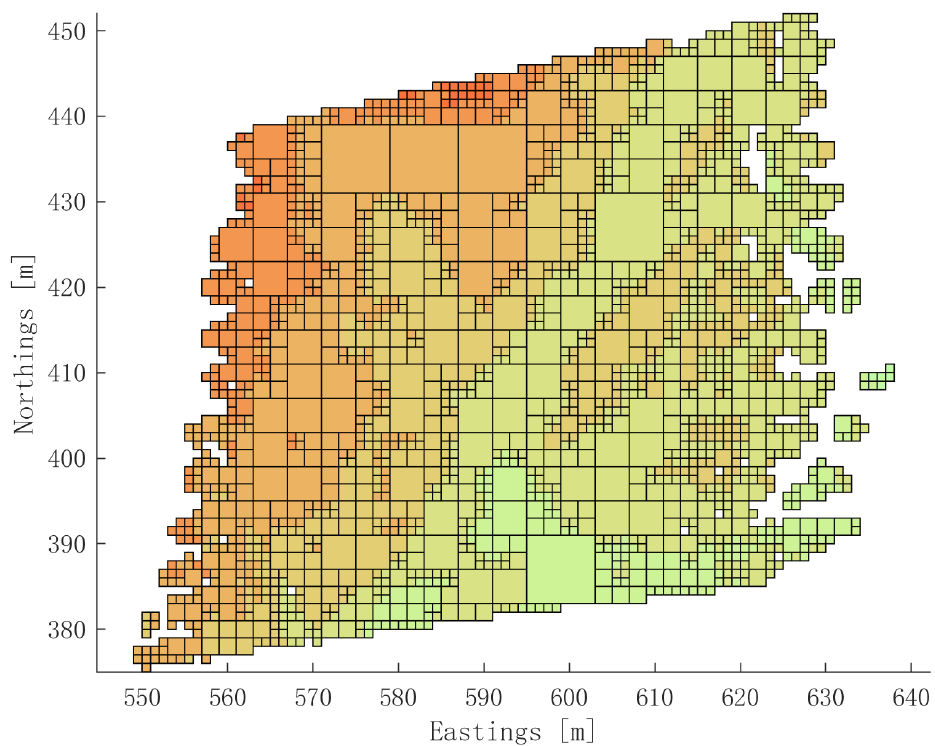
Figure 9. A representation of the test map as Quadtree-based map. Table 1. Comparison table of the four